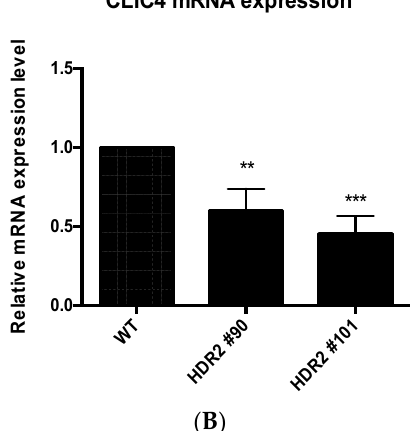
Figure 6. Mutation of the PG4-3 sequence at the endogenous CLIC4 promoter. ( A ) Schematic diagram of the pop-in (‘In’) and pop-out (‘Out’) steps taken to modify PG4-3 to Mutant No. 3 in the CLIC4 promoter. Briefly, in the pop-in step, CRISPR-Cas9 targeting by CLIC4 sgRNA occurred next to the mutated site, and the HDR-1 donor templates consisting of a 1 kb sequence of CLIC4 homology arms left and right (HAL and HAR, respectively), was interrupted by a fluorescence cassette: green fluorescent protein ( GFP ), mCherry , or blue fluorescent protein (BFP ) gene driven by a CMV promoter and tagged with a lacZ sequence at both ends were introduced into the A375 cells. The lacZ sequence does not exist in the human genome and was later used in the pop-out step. Fluorescence-activated cell sorting (FACS) was used to isolate cells co-expressing the three fluorescence markers; primers ‘a’ and ‘b’ were used to check the genomic DNA size. In the pop-out step, the fluorescence markers were excised by two double strand breaks (DSBs) at the lacZ sites. The DSBs were repaired using the HDR-2 donor template. Loss of fluorescence expression in the cells (triple negative cells) were isolated. A TaqMan probe ‘c’, specifically purposed for recognizing the Mutant No. 3 sequence, was used to select clones for further sequencing of the PCR products that were generated with primers ‘a’ and ‘b’. Cleavage points are indicated by scissors; grey X represents homologous recombination; mutation site of Mutant No. 3 is shown as red box; arrow of a, b and c indicates the direction of synthesis; ( B ) CLIC4 messenger RNA (mRNA) expression level in A375 with the genome edited to the Mutant No. 3 sequence. Total RNA was extracted for RT-PCR and real-time qPCR to analyze the CLIC4 mRNA expression level. Data are expressed as the means ± SD of three replicates. ** p < 0.01, *** p < 0.001 as compared to A375 WT cells.